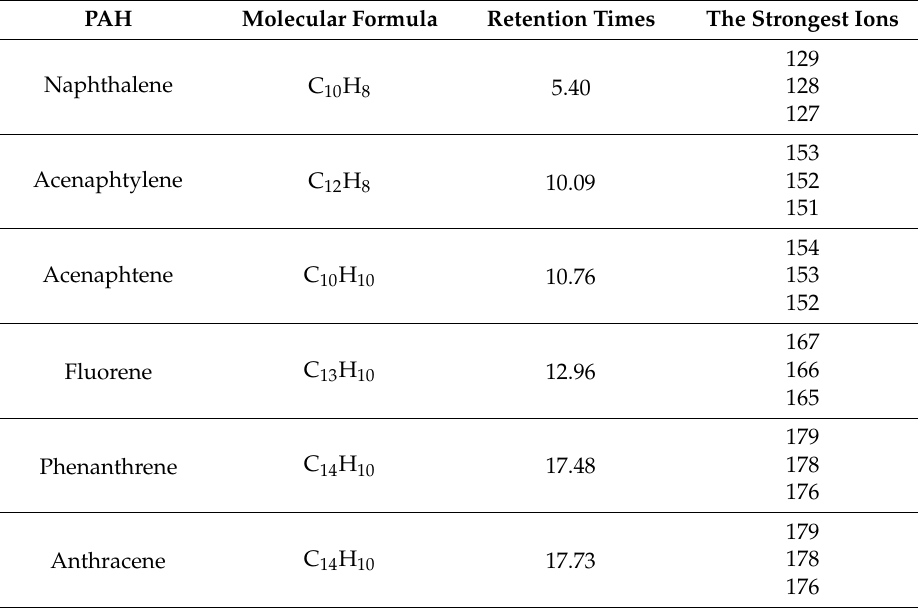
Table 2. Retention times and the strongest ions peaks for